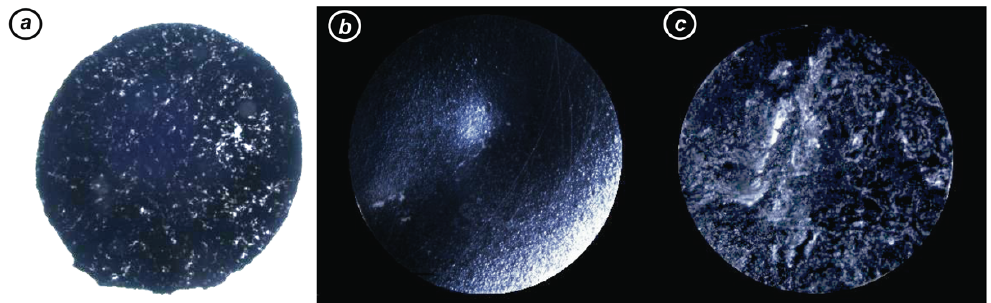
Figure 2. Examples of batch-to-batch variability of scaffold produced manually as described: ( a ) 0.25 wt% CNT@PLLA with nonuniform dispersion as seen with transmission microscopy. White spots were caused by light passing through scaffold because of very low nanofiller concentration; 1 wt% CNT@PLLA with ( b ) valley and hill morphology or ( c ) variable roughness as seen by stereomicroscopy. Here, white spots are reflexes highlighting surface imperfections.